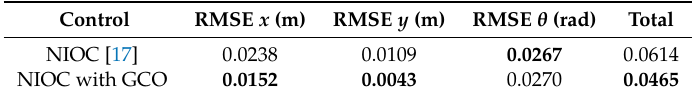
Table 5. Root Mean Squared Error in states for Real-Time experimental test 1. Bold values highlight the best result.